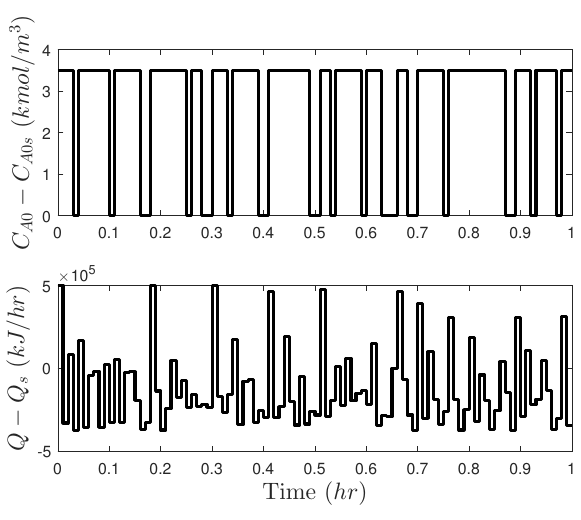
Figure 8. Input trajectories under the randomized LMPC implementation strategy for the CSTR of Equations (46) and (47).